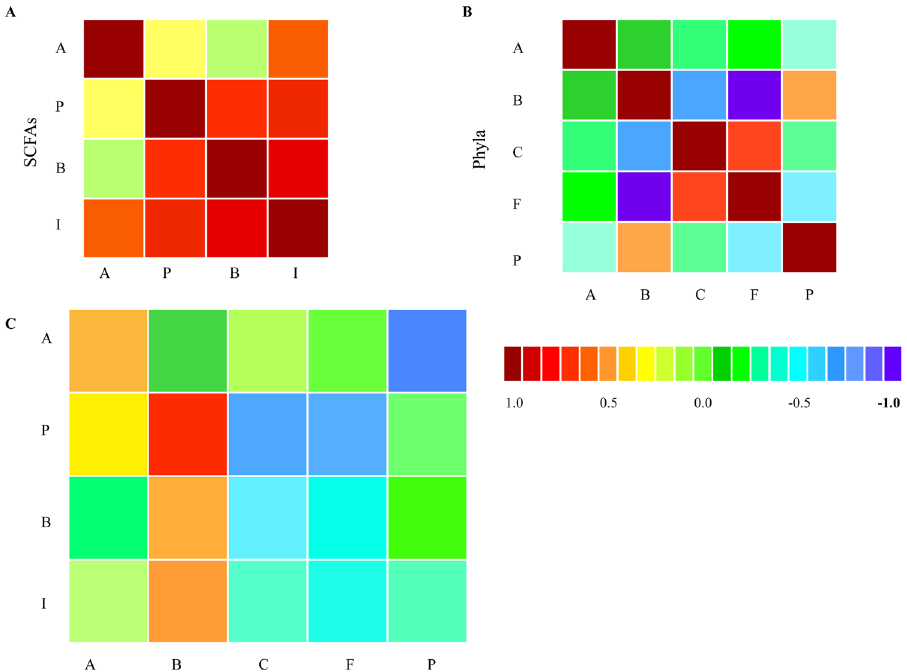
Figure 5. Relationships between phyla abundances and SCFA concentrations in chicken cecal samples. ( A – C ) Correlation matrices: ( A ) SCFAs (A, acetate; P, propionate; B, butyrate; I, isobutyrate); ( B ) Phyla (A, Actinobacteria ; B, Bacteroidetes ; C, Cyanobacteria ; F, Firmicutes ; P, Proteobacteria ); ( C ) Cross-correlation between phylum abundances and levels of SCFAs. The color scale indicates correlation levels: Positive correlation values are in red; Negative correlation values are in